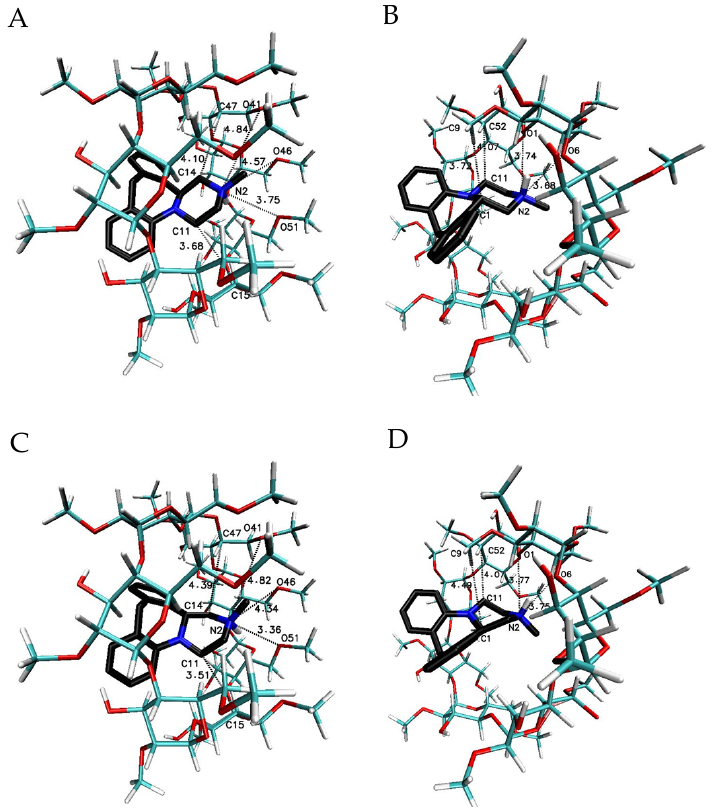
Figure 10. The chosen geometry of the MIA–DM β -CD and MIA–RM β -CD complexes with stoichiometry 1:1 obtained by MD simulations with the use of DM β -CD or RM β -CD crystal structure with refcode BEFJOL for DM β -CD and JOSWOD for RM β -CD from the CSD data base [40,41]; ( A ) or ( B ) for S-(+)-MIA · HCl and ( C ) or ( D ) for R-( − )-MIA · HCl.